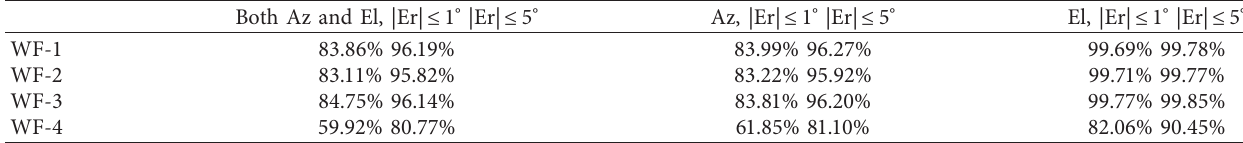
Table 7: Array-3 probability of AoA estimation using 1025 snapshots (0dB ≤ SNR ≤ 10dB).